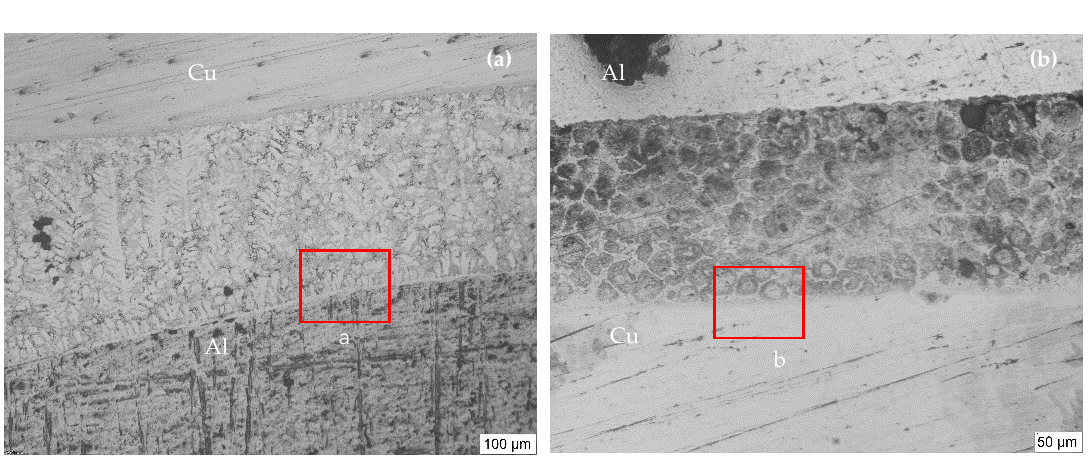
Figure 3. ( a ) brazing Al/Cu without ultrasonic; ( b ) semi-solid brazing Al/Cu with ultrasonic.